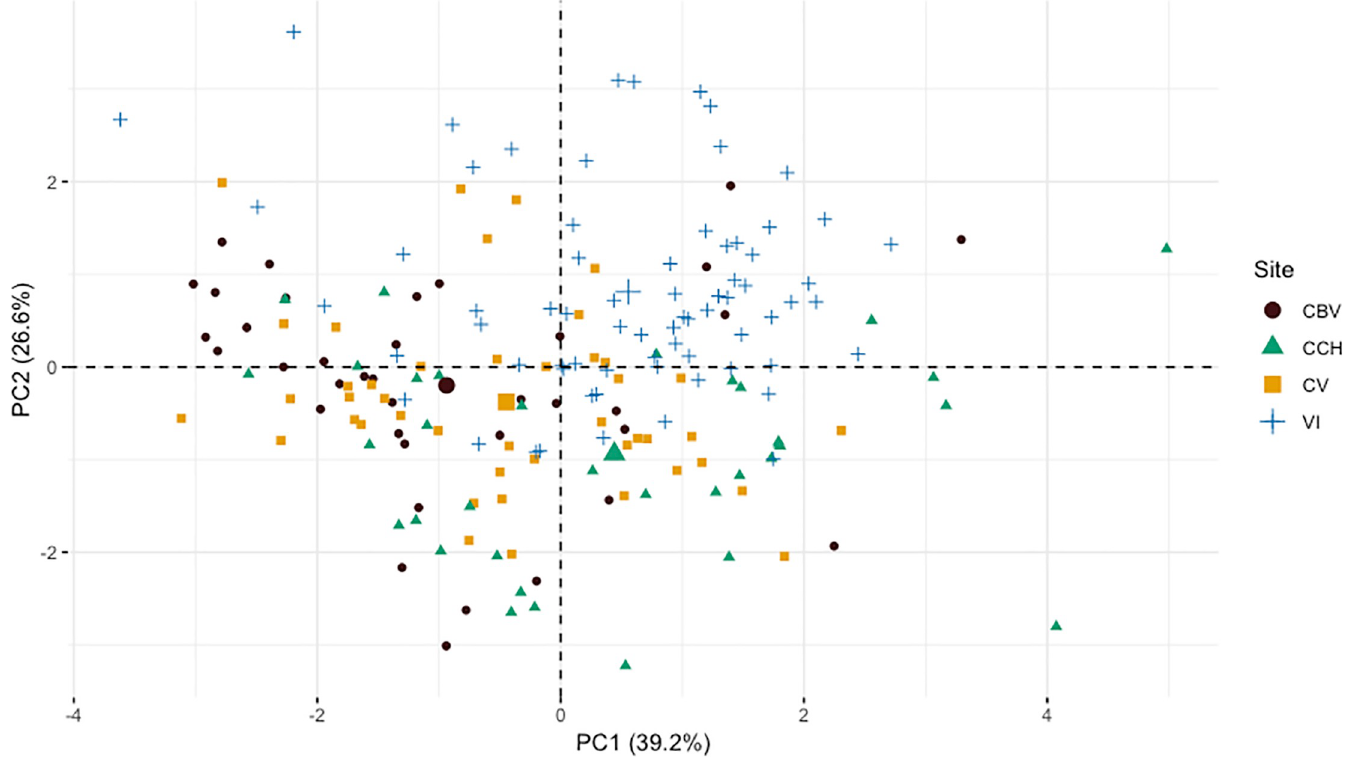
Fig 4. Principal component analysis plot using the first two components of six T . browni song acoustic traits. CBV = Cerro Buena Vista, CV = Cerro Vueltas, CCH = Cerro Chirripo´, IV = Irazu´ Volcano.